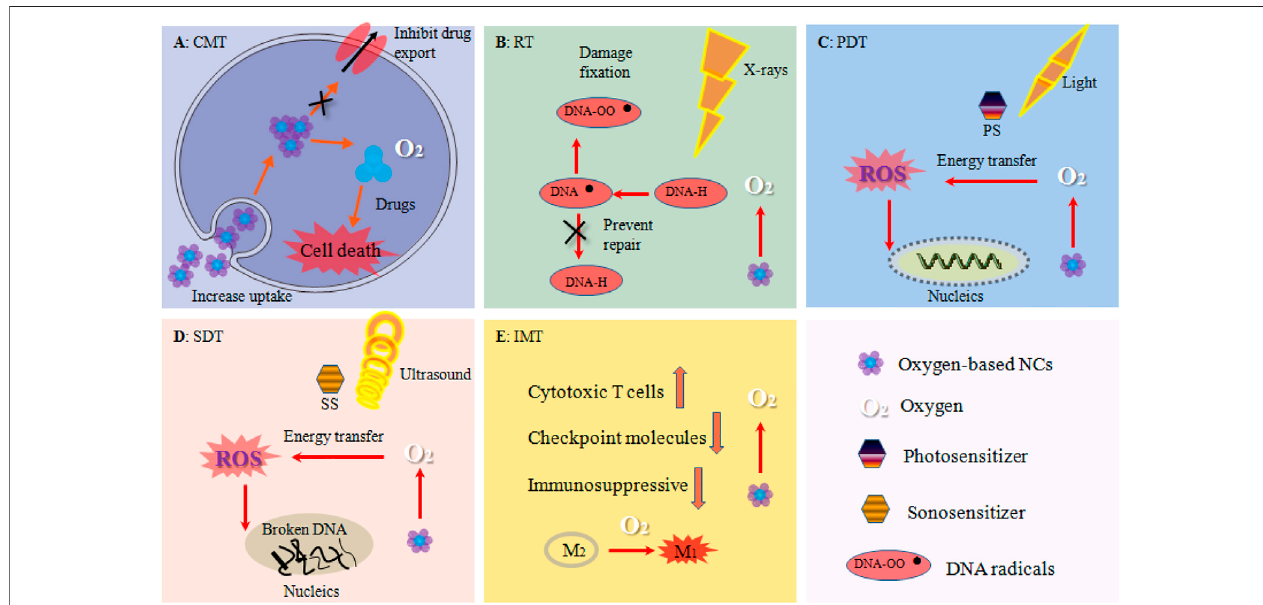
FIGURE6| Oxygen-basedNCsboostedtumortherapies. (A) CMT:alleviatedhypoxiadecreasedtheexpressionofdrugef fl uxpumpssuchasP-gpandincreased drugsuptakebytumorcells. (B) RT:oxygenstabilizedDNAdamagesandpreventedDNAself-repairbycells. (C) PDT:oxygenenhanced thegenerationofROSsuchas 1 O 2 . (D) SDT: elevated ROS level enhanced DNA broken. (E) IMT: oxygen increased the number and activity of cytotoxic T cell, down-regulated the expression of important immune checkpoint molecules such as PD-L1, changed the immunosuppressive TME, tilted the polarization of TAM from the M2 phenotype to the tumor-inhibiting M1